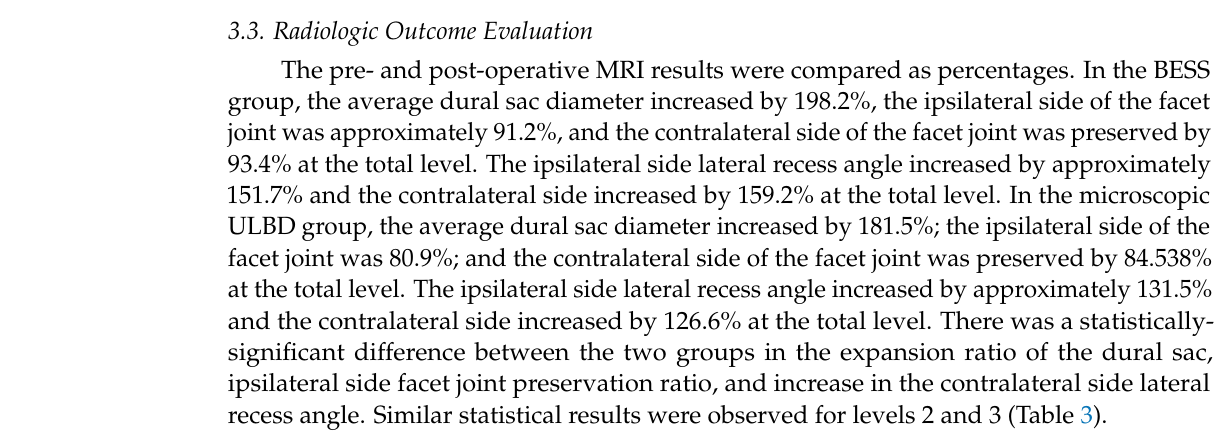
Table 3. Radiological outcomes by range of surgical